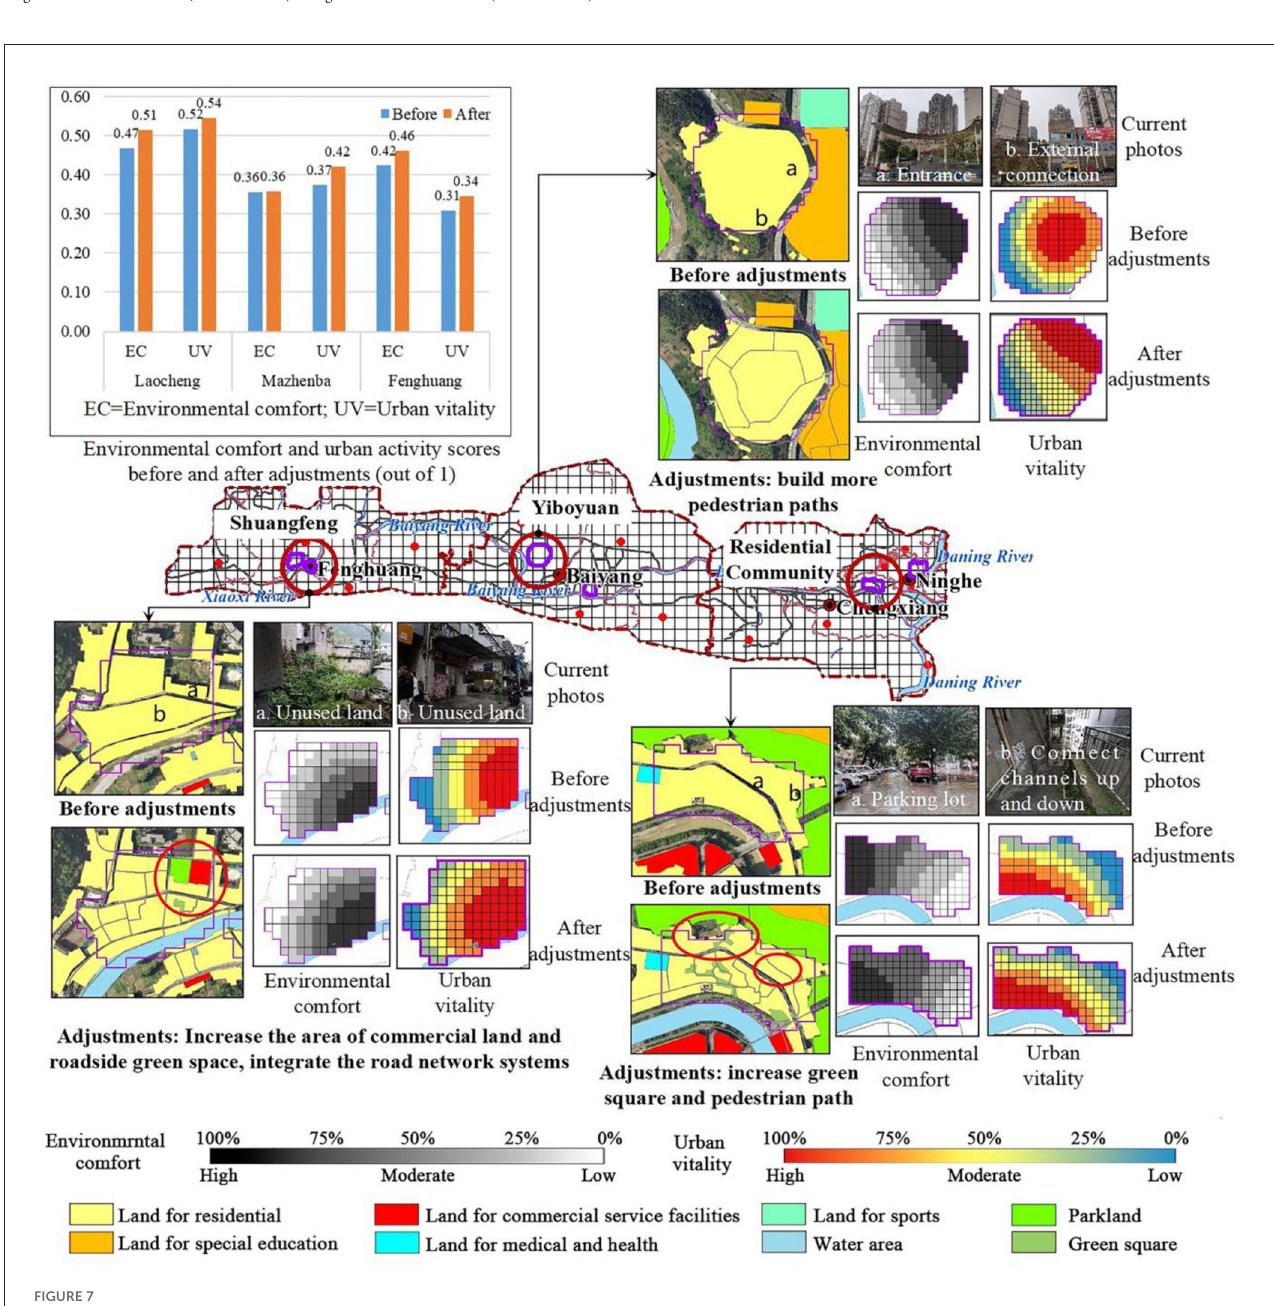
the internal connectivity of residential areas. The adjustments slightly reduced the building density and improved the green